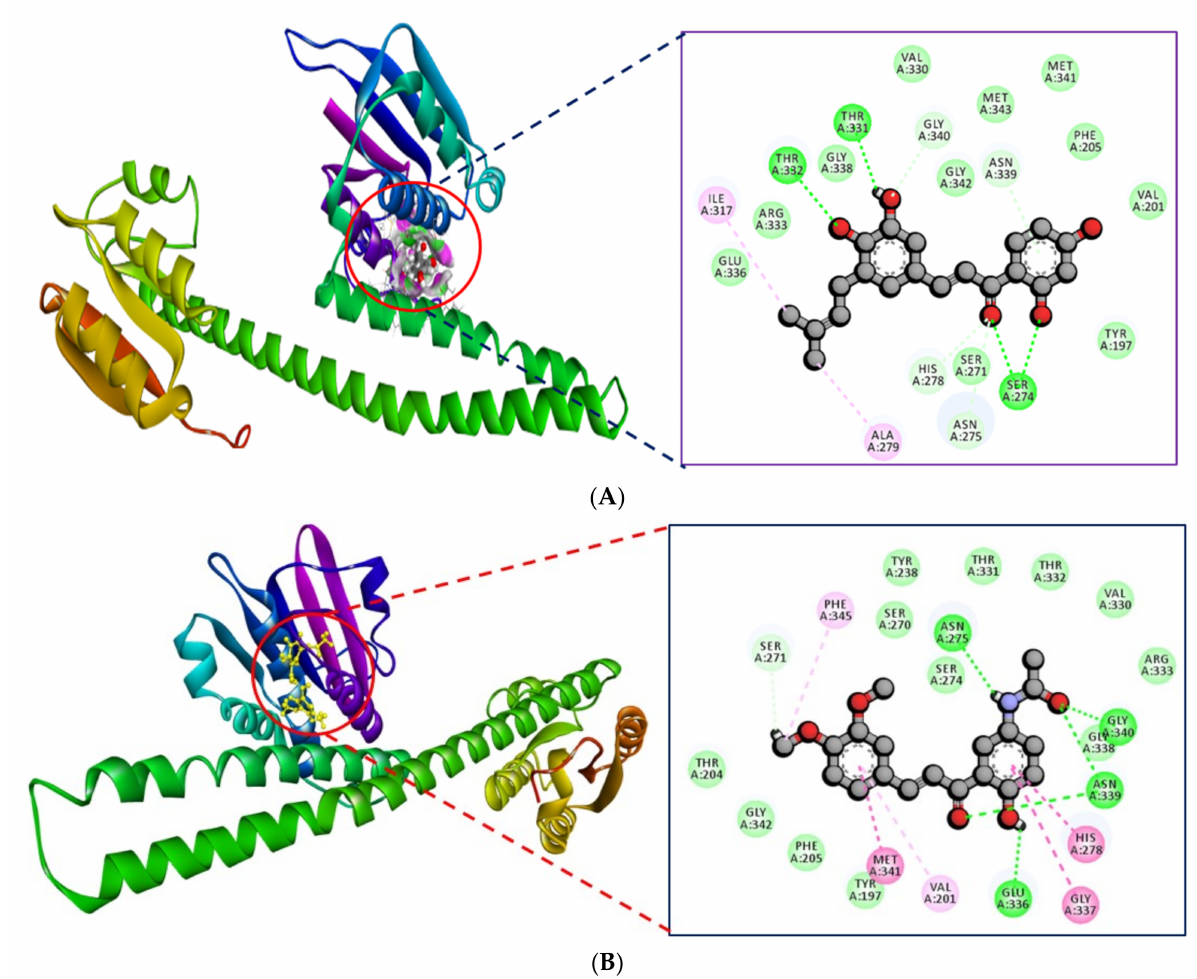
Figure 3. ( A ) Interaction of PhcR with ZINC000014762512. ( B ) Interaction of PhcR with